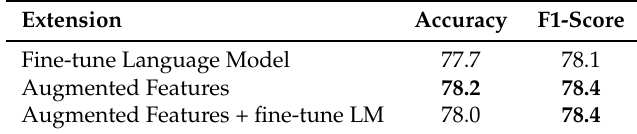
Table 4. Classifier prediction results for extensions to BERT model.